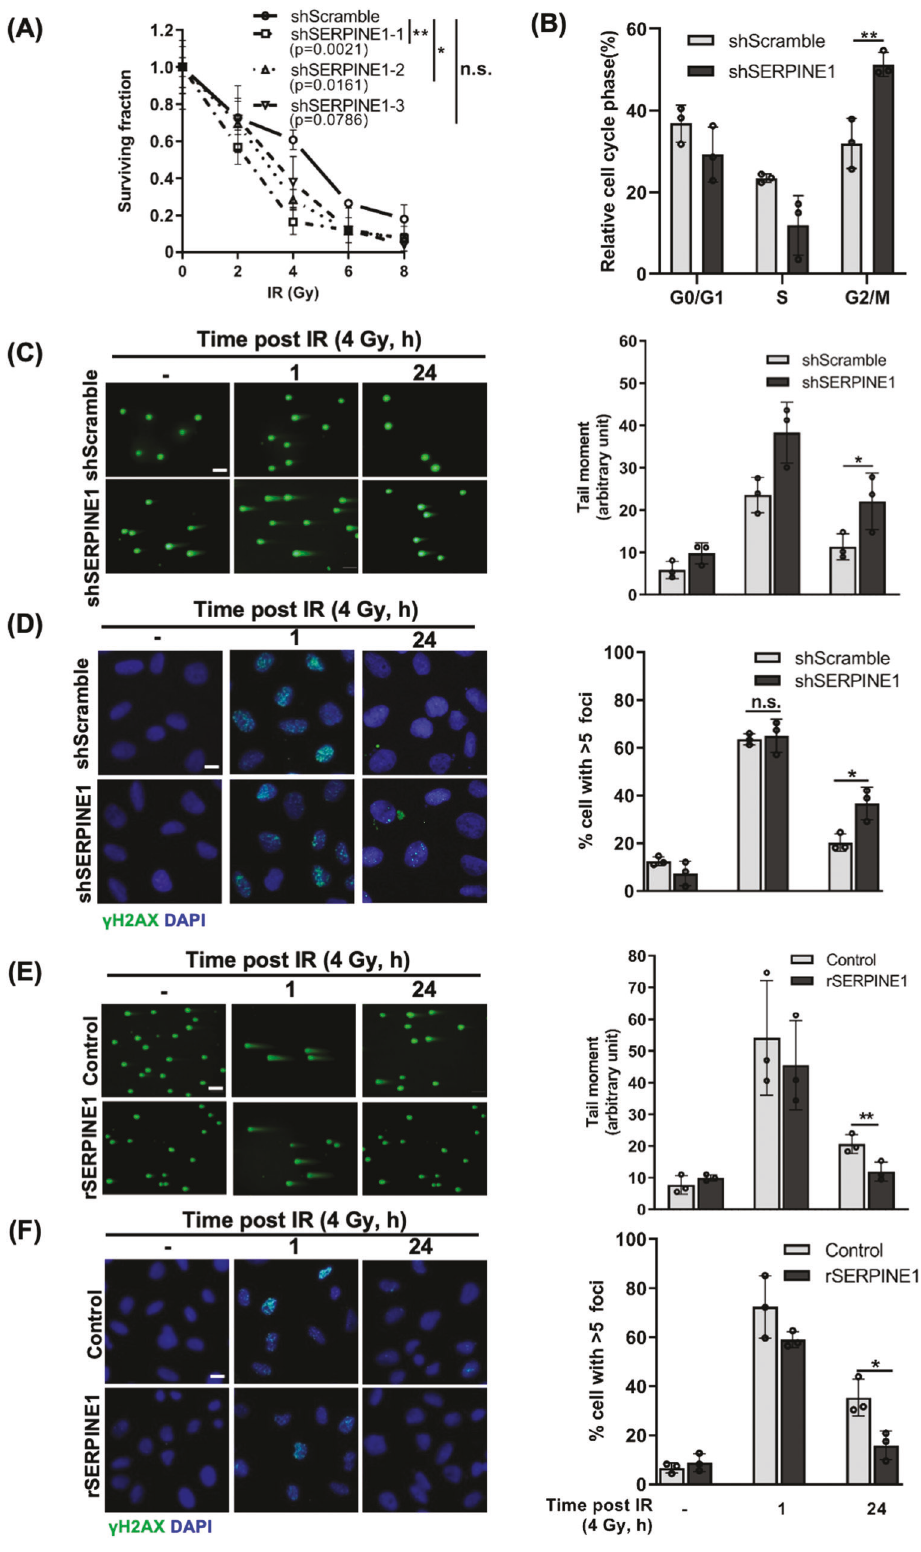
phenotypes such as migration (Figs. 5F, S6C), invasion (Figs. 5G, S6D), and stemness capacity (Figs. 5H, S6E). In conclusion, SERPINE1 secreted by hAd and expressed in MDA-MB-231 cells contribute to the development of radioresistance under obesity- mimicking